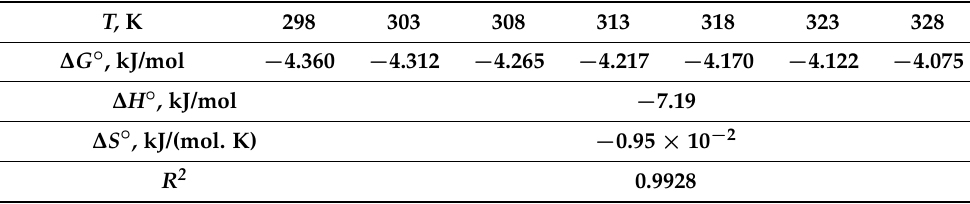
Table 5. The thermodynamic U(VI) sorption settings. T, K